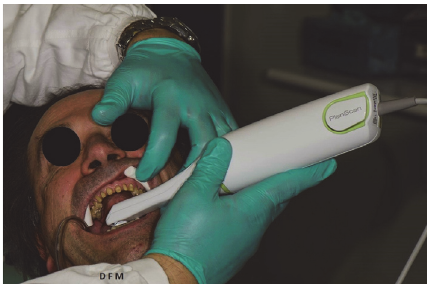
Figure 6: Development of the 3D design project of the definitive